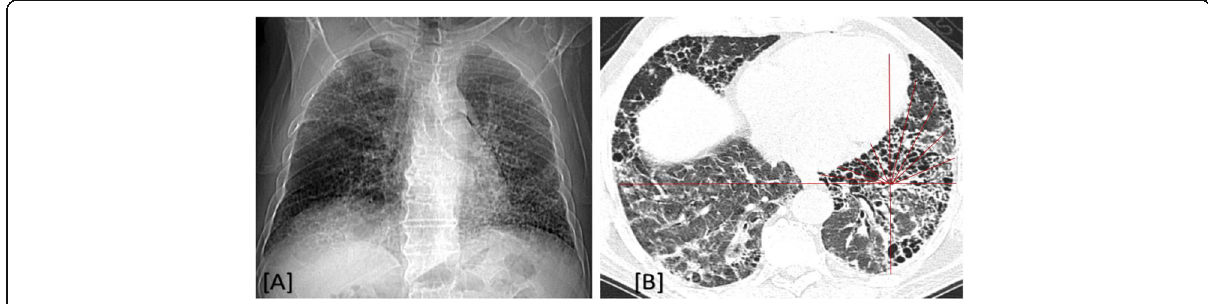
Fig. 8 A 55-year-old patient with active hepatitis complaining from progressive dyspnea with restrictive PFT. a X-ray chest PA view. b Axial CT chest (lung window). Both showing extensive fibrotic changes, and honey combing bronchiectasis is more pronounced in lower lung zones. Slices visual semi-quantitative assessment of fibrosis done in CT. UIP